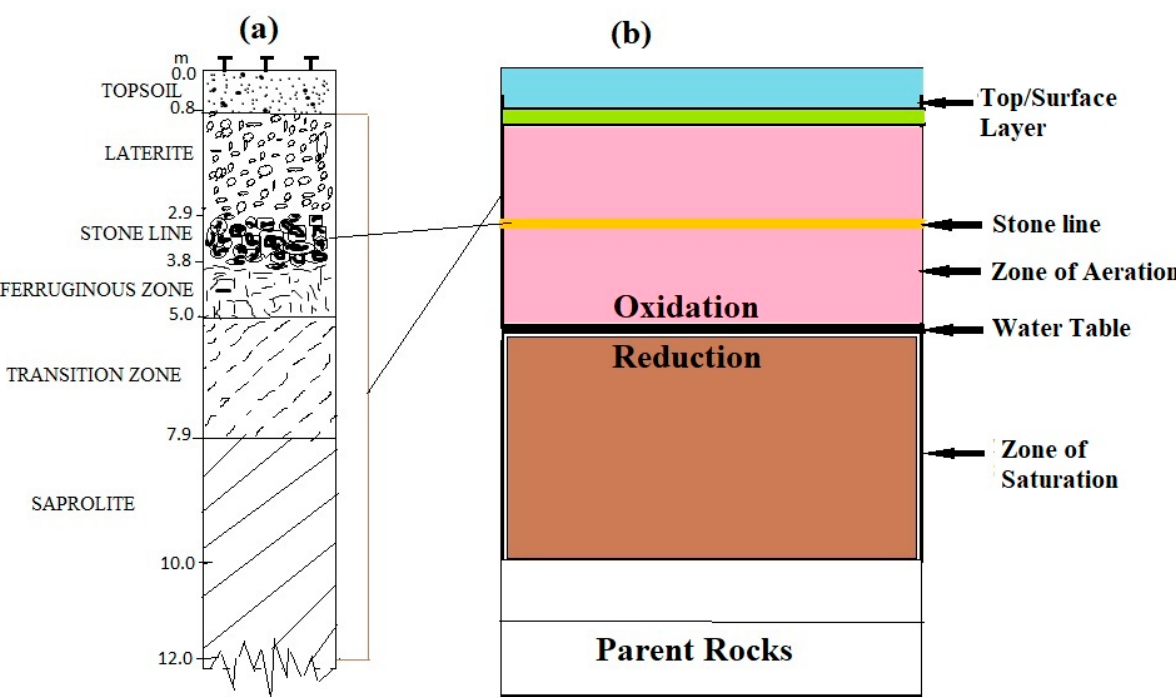
Figure 2. ( a ) Schematic section of the Kubi soil profile; ( b ) Schematic section of ground profile showing Au auriferous lodes.